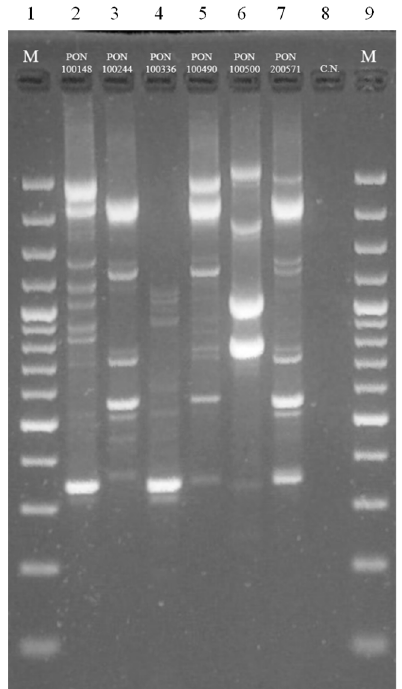
Figure 4. Randomly amplified polymorphic DNA (RAPD)-PCR profiles of LAB added as starter strains obtained with primer M13. Lanes: 1 and 9—GeneRuler 100 bp plus DNA ladder; 2— L. plantarum PON 100148; 3— L. graminis PON 100244; 4— L. sanfranciscensis PON 100336; 5— L. curvatus PON 100490; 6— L. rossiae PON 100500; 7— L. brevis 200571; 8—negative control.